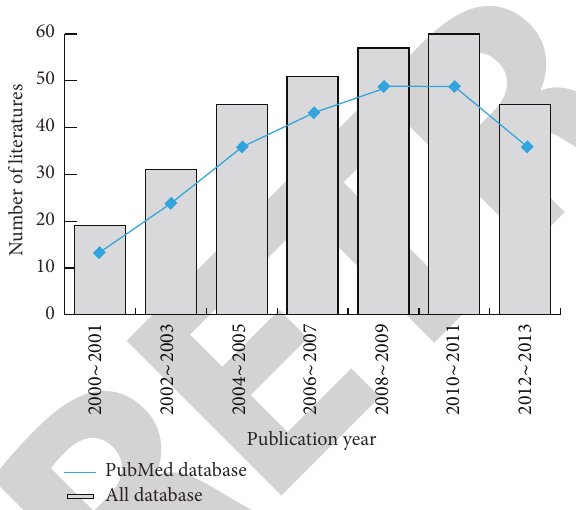
Figure 2: Distribution of the number of topic-related literatures in the electronic database during the last decade.